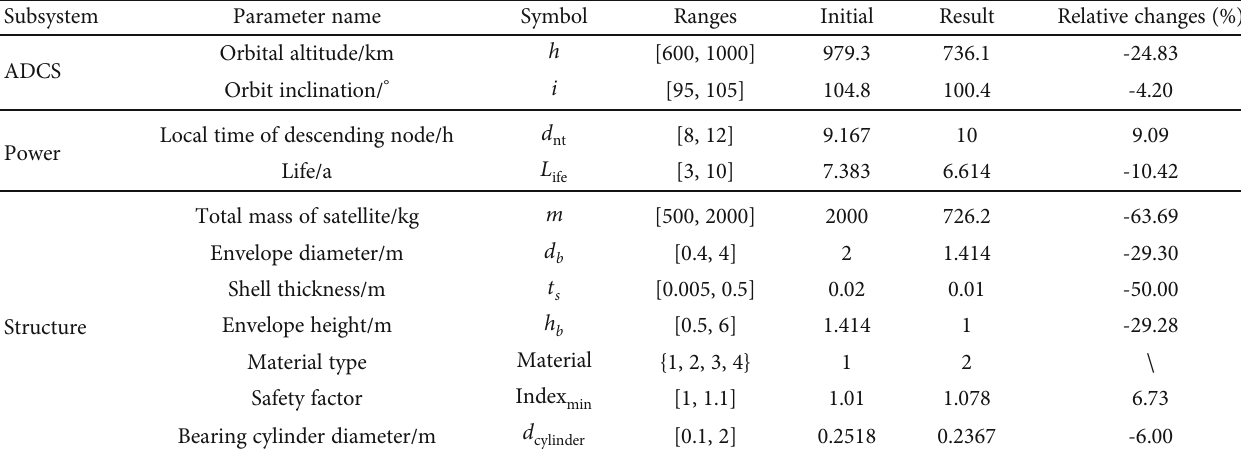
Table 3: Bounds, initial value, and optimization results of system-level design